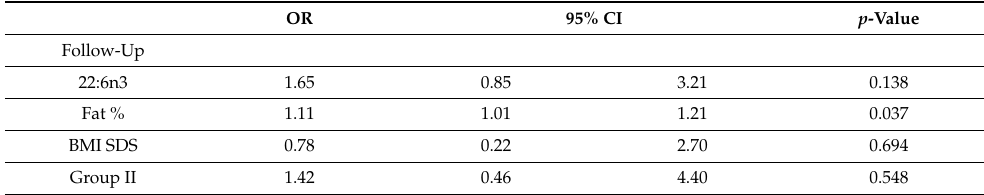
Table 2. Logistic regression showing the association between VDD (dependent variable) and inter- ventional arm, percentage of fat, BMI status and DHA levels at the end of the study. OR 95% CI p